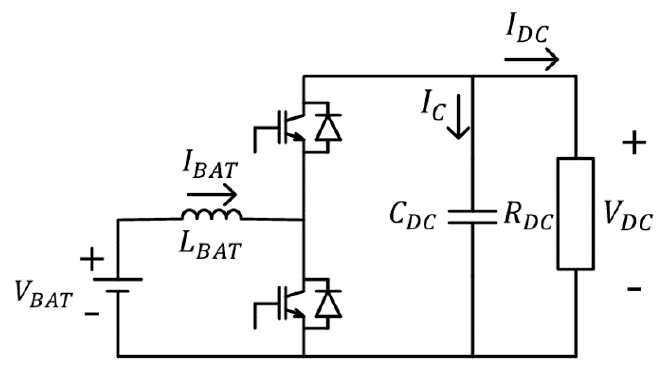
Figure 5. Equivalent circuit of the BESS converter.